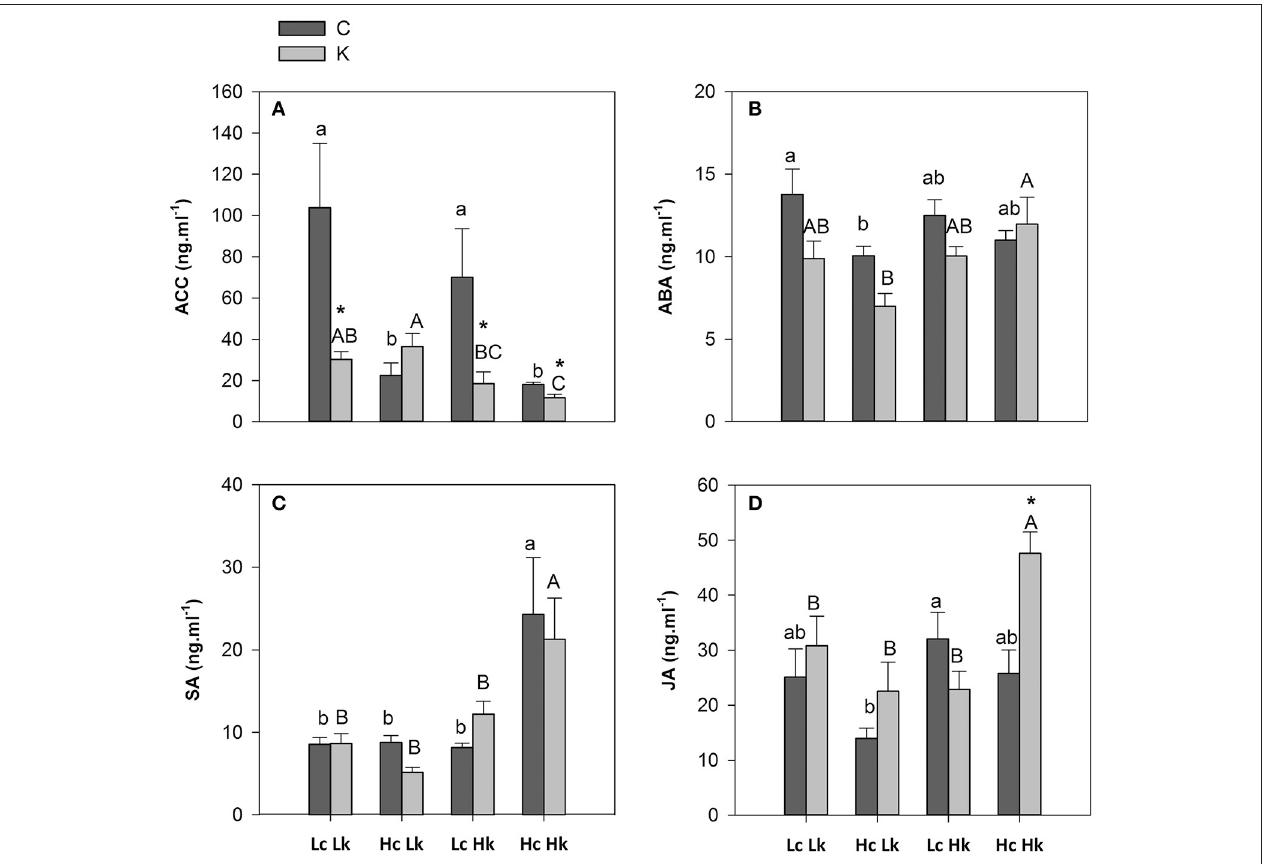
FIGURE 5 | 1-Aminocyclopropane-1-carboxylic acid, ACC (A) , abscisic acid, ABA (B) , salicylic acid, SA (C) , and jasmonic acid, JA (D) concentrations in the root xylem sap of the scion ( Solanum lycopersicum cv. Boludo F1) grafted onto a population of recombinant inbred lines (RILs) from a cross between Solanum lycopersicum × Solanum pimpinellifolium with high ( H ) or low ( L ) vigor growing under control ( c ) and low K ( k ) conditions during 48 days. Different letters indicate significant differences among graft combinations ( n = 12, P < 0.05) within each treatment. *indicate significant differences between control and low-K treated plants according to the Tuckey test ( P <